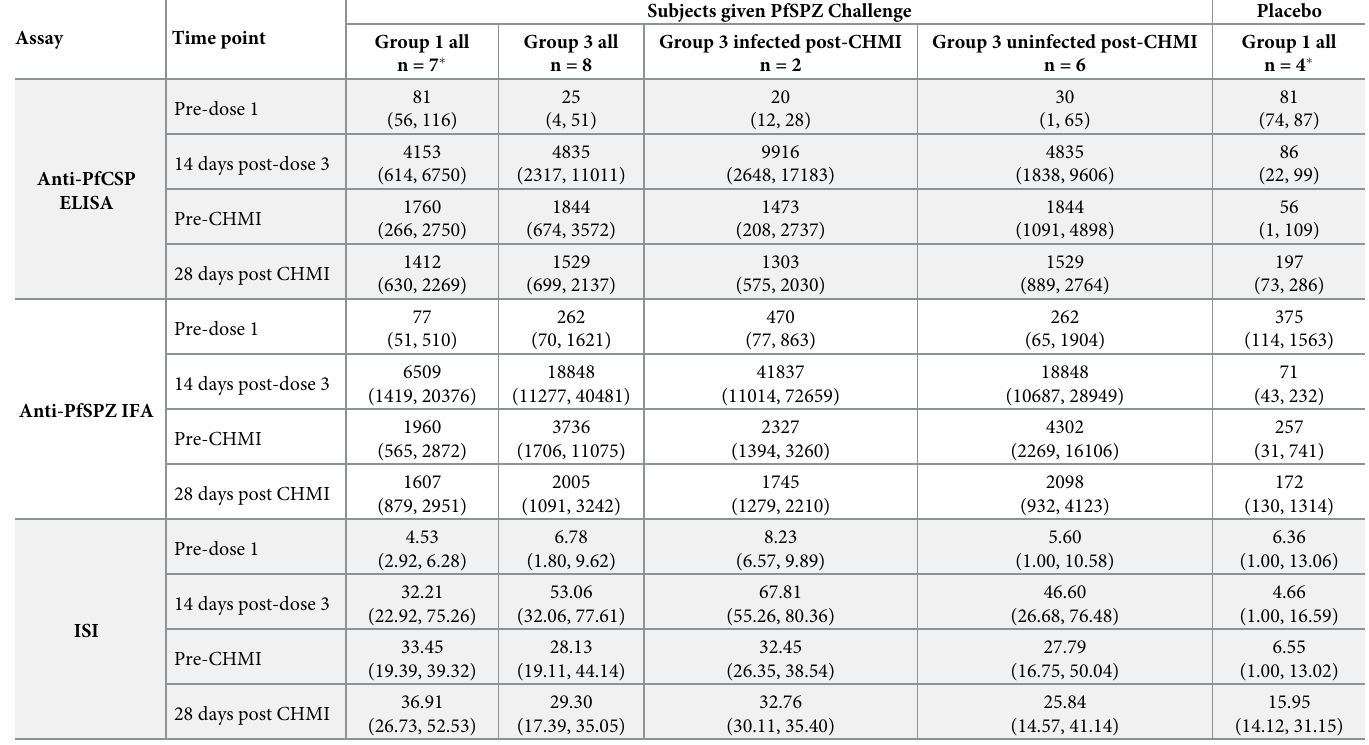
Anti-PfCSP ELISA = median serum dilution at which the optical density was 1.0. Anti-PfSPZ IFA = median serum dilution at which the arbitrary fluorescence units were 2.0x105. ISI = median serum dilution at which there was 80% inhibition. � All Group 1 vaccinated subjects and placebo subjects were infected after